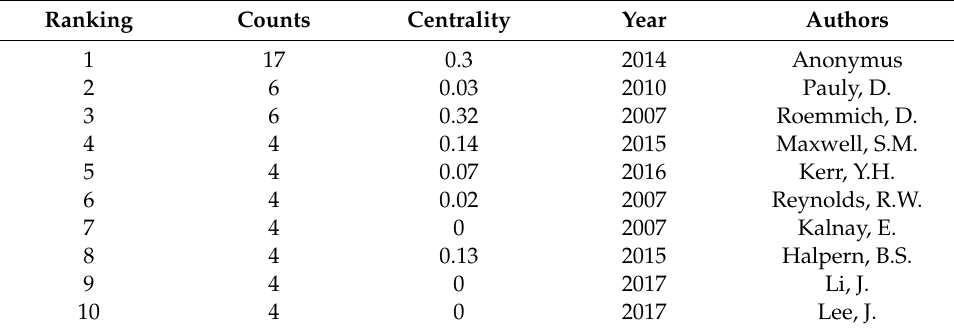
Table 5. Top 10 most cited authors of big ocean data